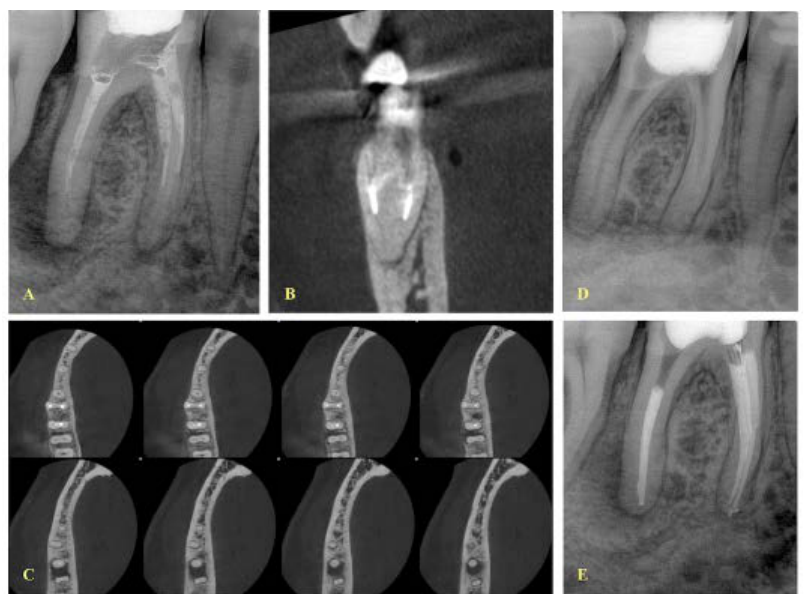
Figure 2. ( A ) Initial periapical radiograph (mesial angle view) of a mandibular first molar with periapical lesions and an instrument fracture at the middle third of the mesial root. The fragment is located at the mesiobuccal canal, according to the buccal-object rule. ( B ) CBCT coronal view indicating that the two canals are separate, ( C ) axial views demonstrating that the two canals are separate, however the two apical foramina are very close to each other, ( D ) radiograph after the removal of the fragment. ( E ) Final radiograph. 3. In cases where the canals were merging, then a final treatment plan of leaving the fragment in situ was set, irrespective of the presence or absence of lesions (Figures 3 and 4). The only occasion that would induce a modification to this treatment plan (i.e., leave the fragment in situ) was to conclude, after CBCT assessment and evalua- tion of canal curvature, that the removal of the fragment located at the middle level of the root would not be of a high difficulty degree procedure (Figure 5).